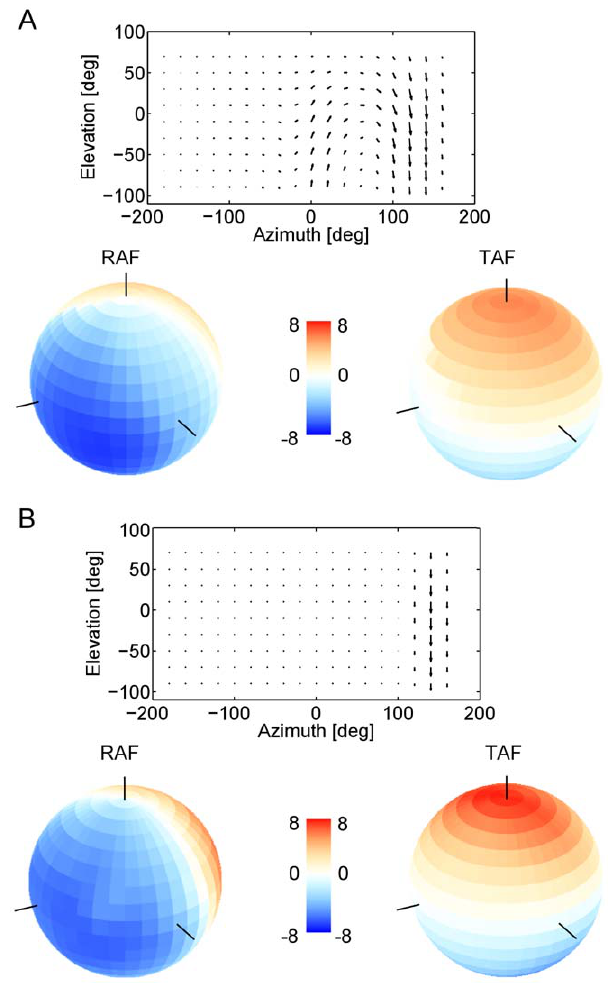
Figure 9. Receptive field and rotational/translational action fields of VS10, given full connectivity within the network (a), and with all network connections removed (b). The internal connectivity has a strong influence on the receptive field and the selectivity of the response for rotation over translation, but no influence on the tuning width for rotations.